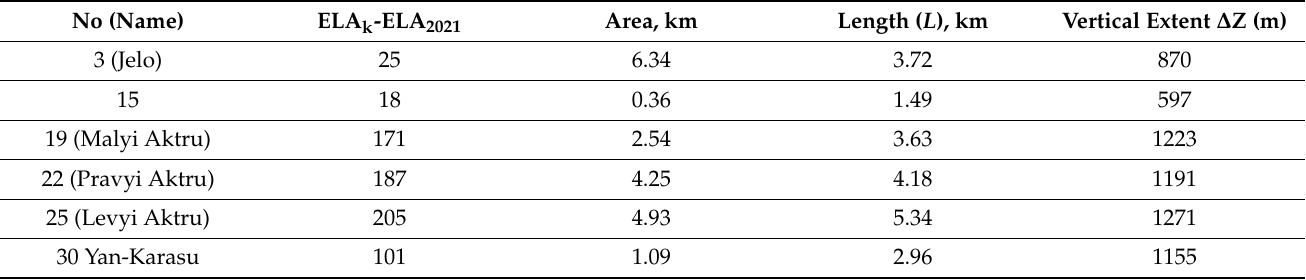
Table 3. The difference between the ELA calculated by the Kurowski method (ELA k ) and obtained from satellite imagery (ELA 2021 ) for the valley and the characteristics of the